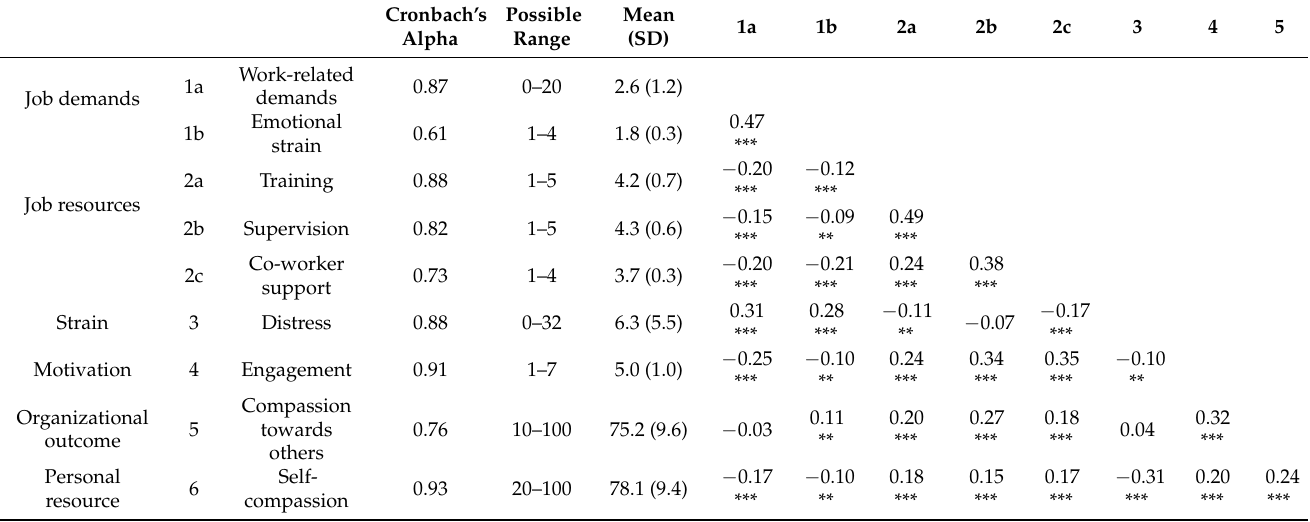
Table 2. Descriptive statistics, correlations, and reliability coefficients for variables of present